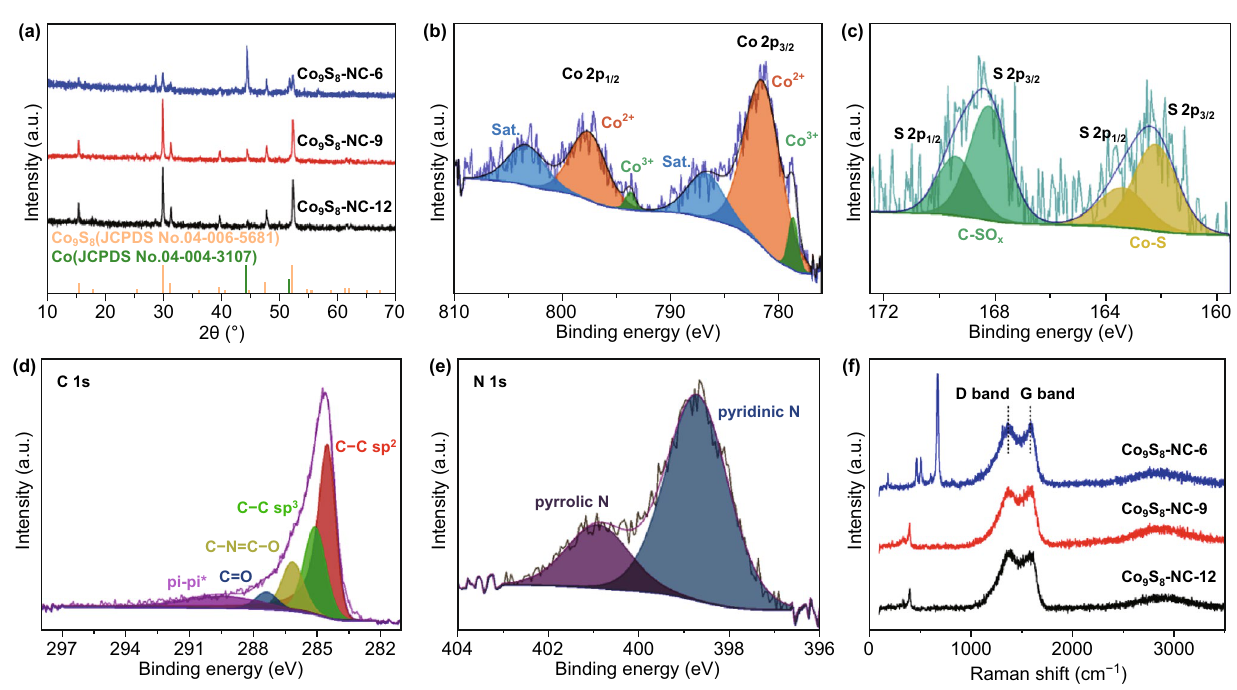
Fig. 1 a XRD pattern of the Co 9 S 8 @NC composites and the standard XRD patterns of Co (JCPDS No. 04-004-3107) and Co 9 S 8 (JCPDS No. 04-006-5681). b‑e High-resolution XPS spectra of Co 9 S 8 @NC-9. f Raman spectra of the Co 9 S 8